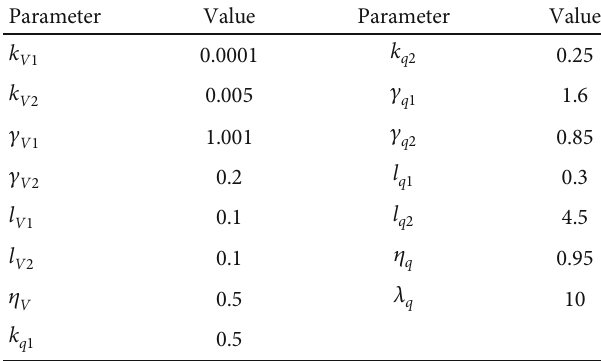
Table 4: Parameters of velocity controller and pitching rate controller.